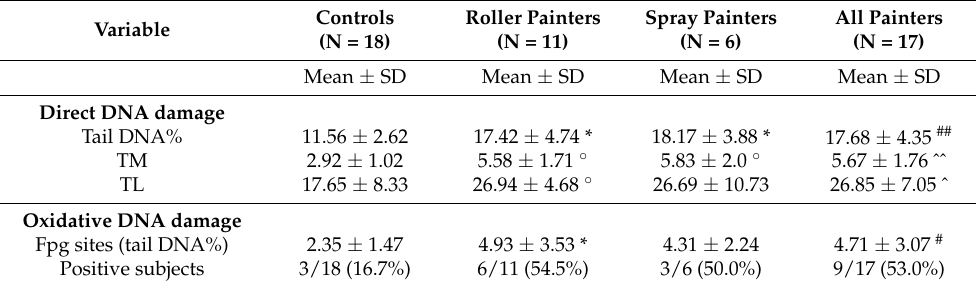
Table 3. Fpg-comet assay results.